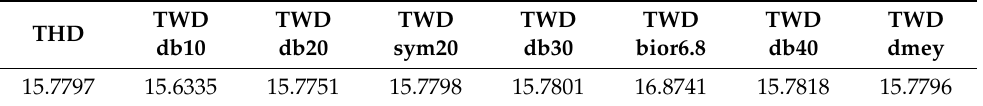
Table 2. Total Harmonic Distortion (THD) and Total Wavelet Disturbance Ratio (TWD) of voltage signal decomposition shown in Figure 2.